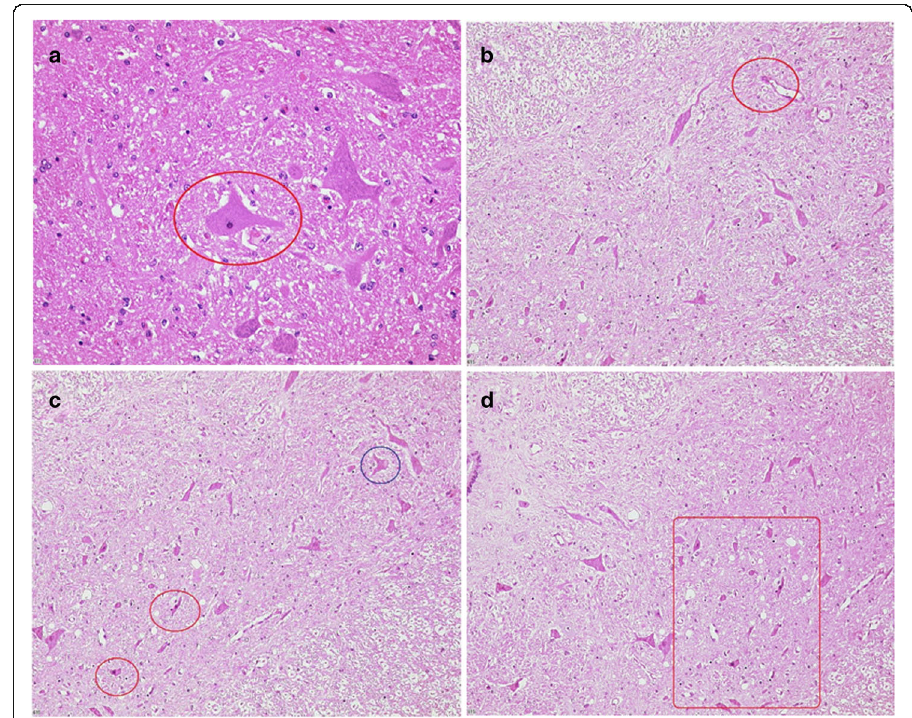
Fig. 2 Histology of the spinal cord of familial hypercholesterolemia Bretoncelles Meishan (FMB) pig. a Red frame marks swollen motor neuron with pyknotic nucleus indicating neuronal damage. b Red frames mark endothelial damage. c Red frames mark ischemic neurons with eosinophilic cytoplasm and darkened, shrunken nuclei. Blue frames indicate the formation of a vacuole within a neuron. d Red frames indicate hypoxic damage with eosinophilic gangliocyte necrosis